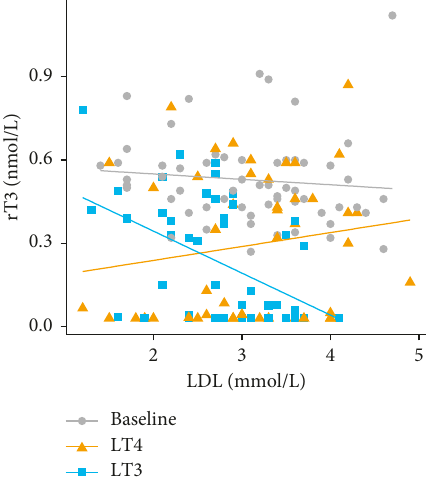
Figure 4: A scatter dot plot showing the association between serum levels of LDL cholesterol and levels of reverse T3 at baseline (grey line), after LT4 treatment (orange line), and after LT3 treatment (blue